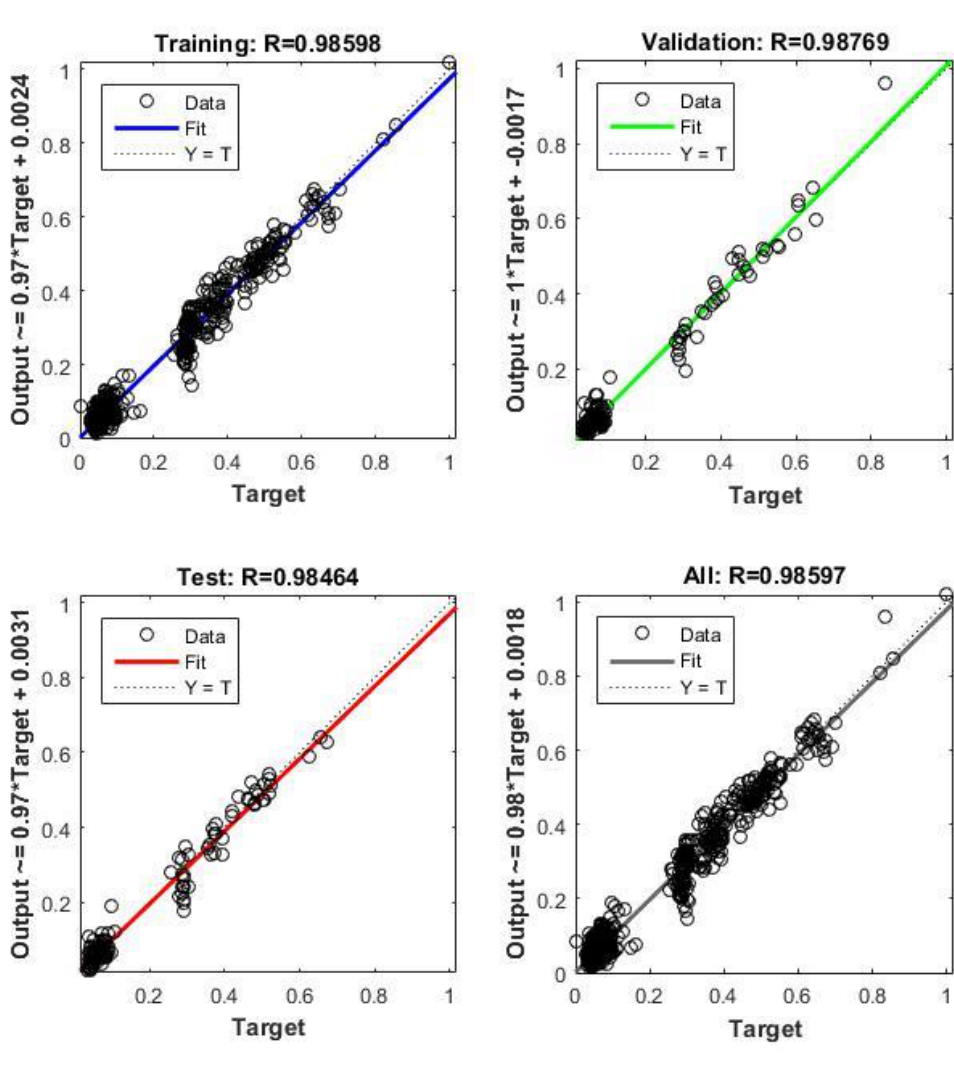
Figure 6. Correlation coefficient curves of the DWQM model.